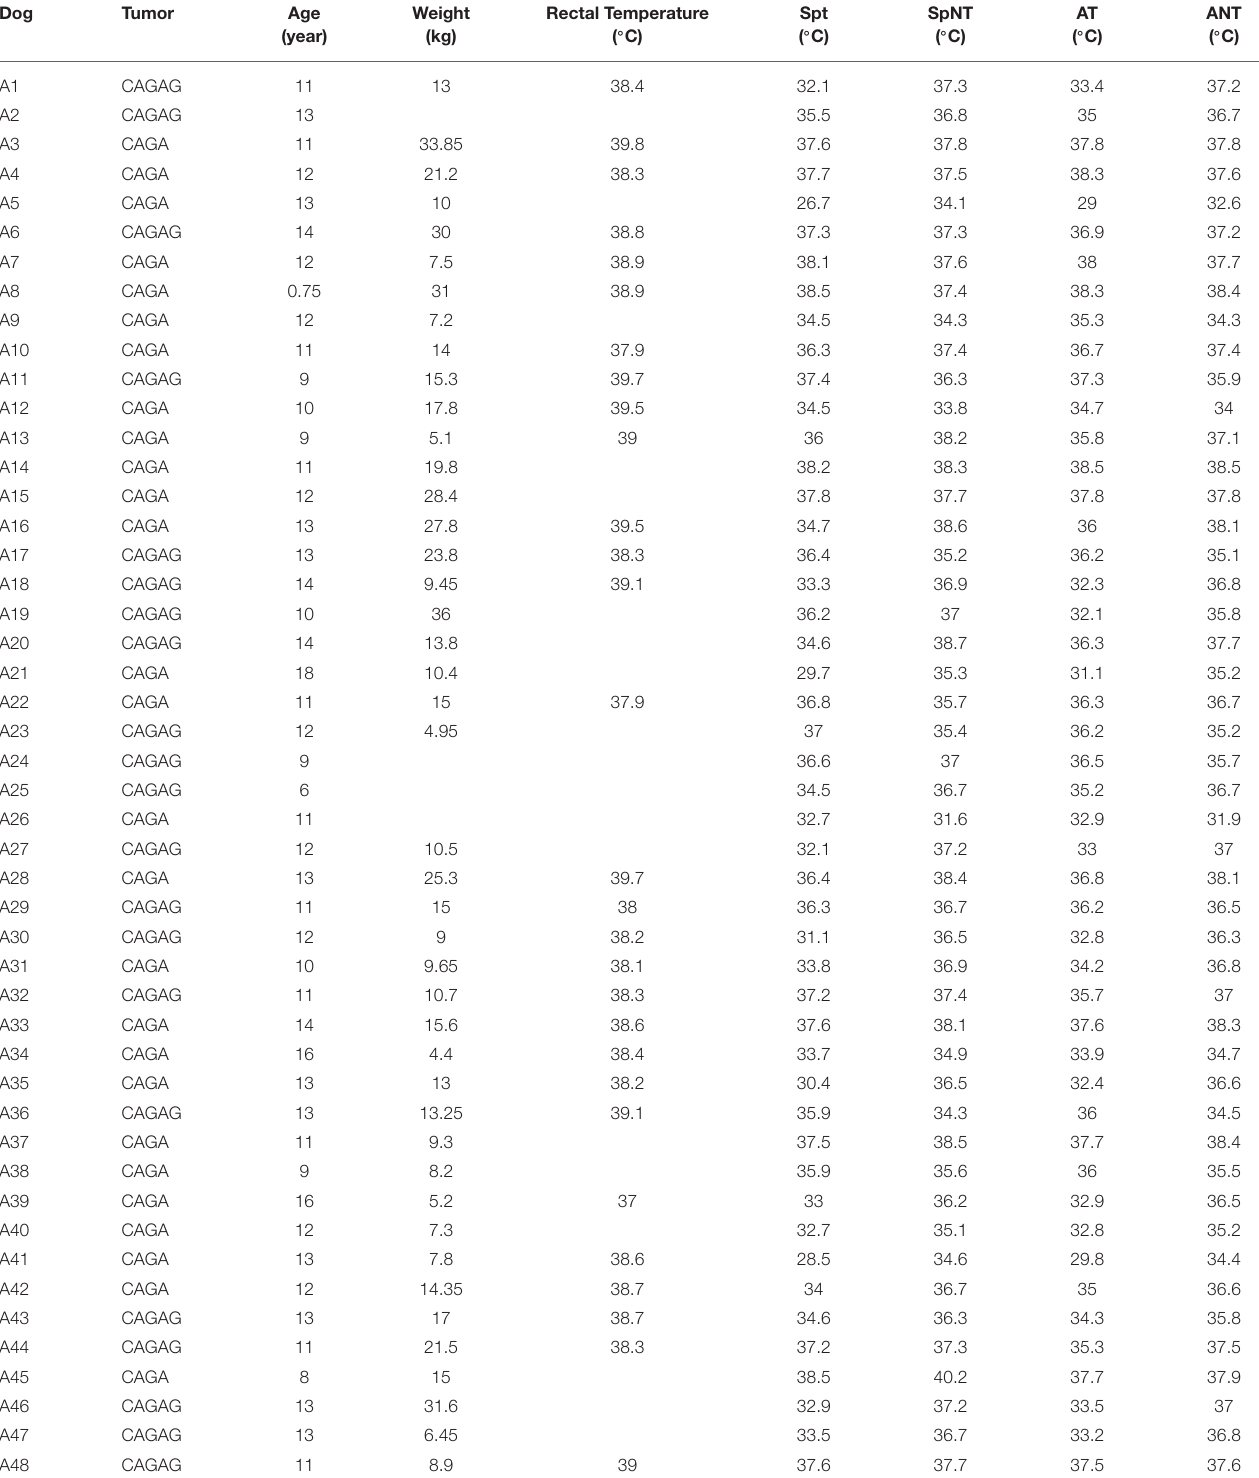
TABLE 1 | Temperature values obtained through thermographic examination of each animal with their respective histopathological examinations, ages, weights, and rectal temperatures.